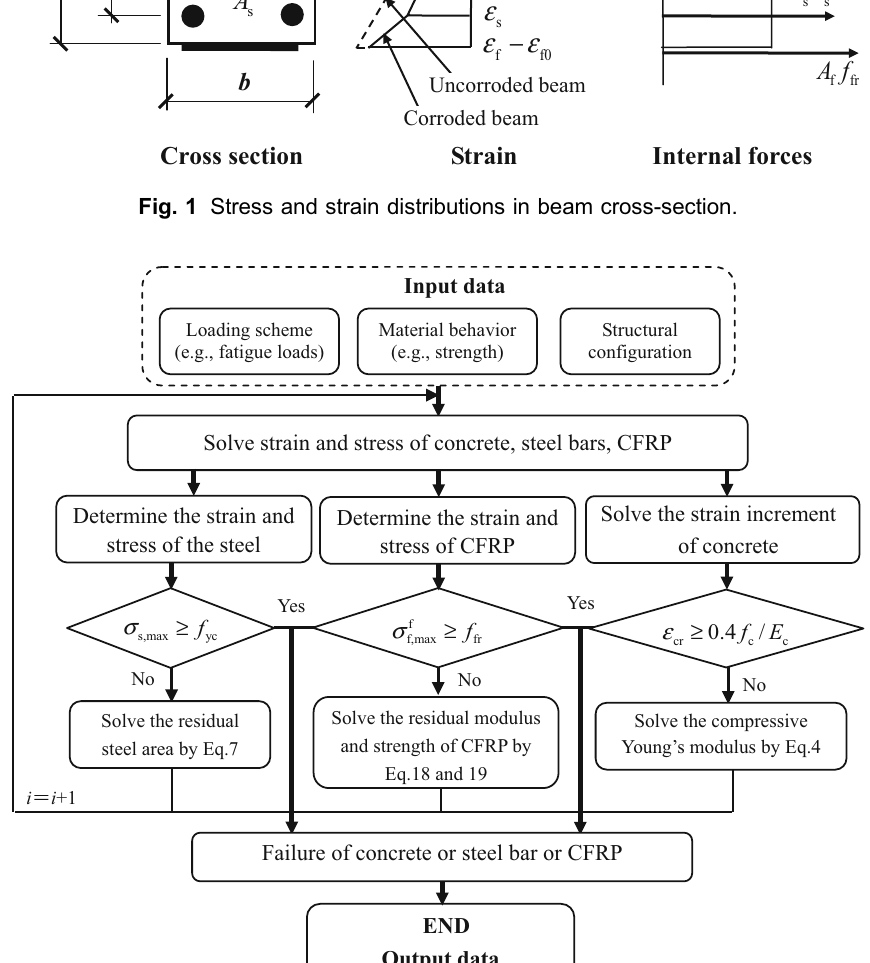
Fig. 2 Fatigue analysis flowchart for the prestressed strengthened corroded